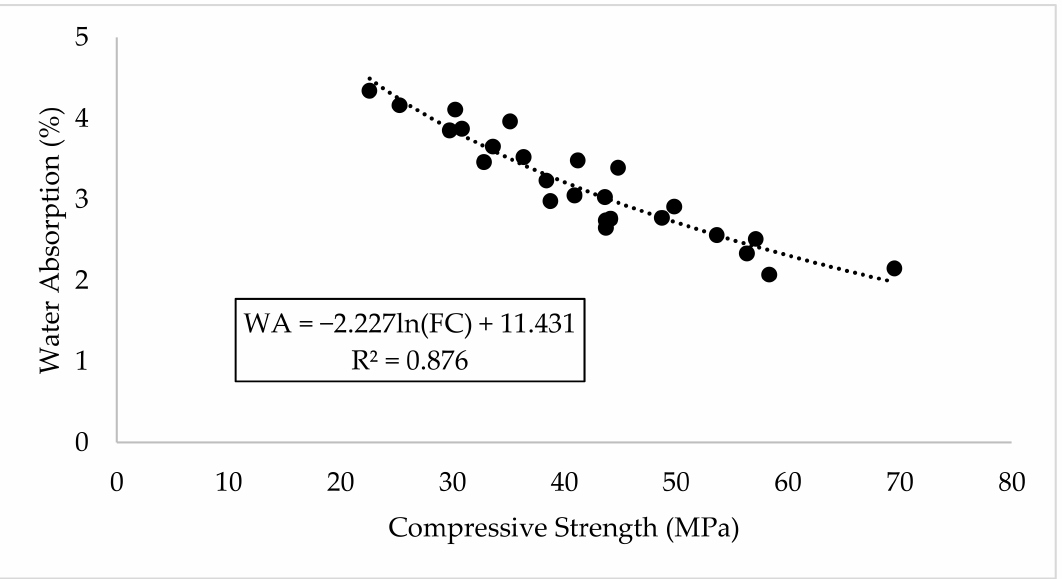
Figure 15. Relationship between Compressive Strength and Water